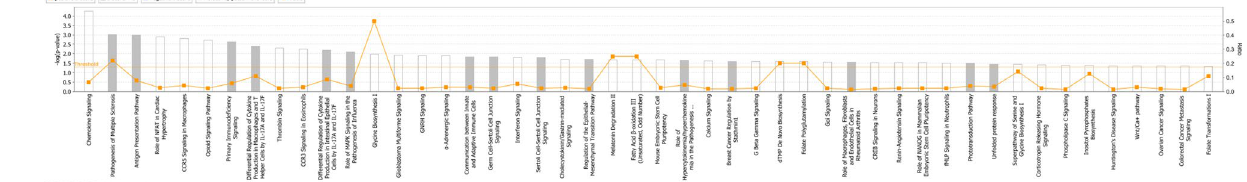
Figure 5. Pathway analysis using the IPA software (https ://digit alins ights .qiage n.com/produ cts-overv iew/ disco very-insig hts-portf olio/analy sis-and-visua lizat ion/qiage n-ipa/). The most highly represented canonical pathways derived from genes located within the candidate regions for Campylobacter colonisation resistance in commercial chickens are shown. The solid yellow line represents the significance threshold. The line joining squares represents the ratio of the genes represented within each pathway to the total number of genes in the